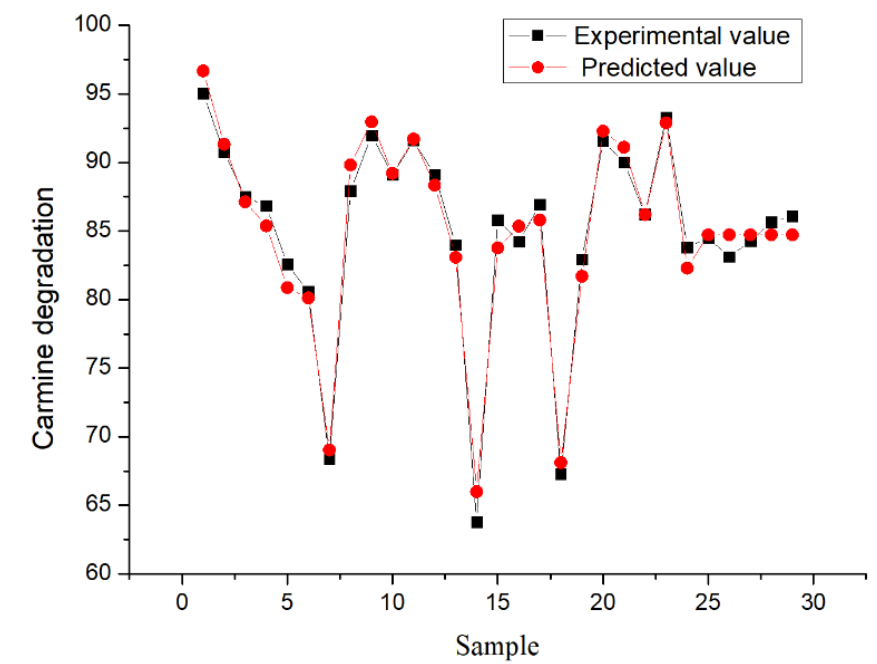
Figure 15. Comparison of experimental and predicted values for RSM. Table 4. Analysis of variance (ANOVA) for the response surface quadratic model.